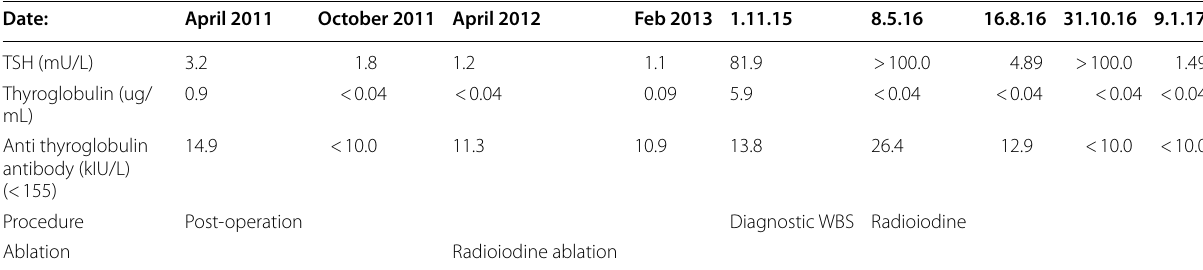
Table 1 Patient’s stimulated thyroglobulin and anti-thyroglobulin antibody